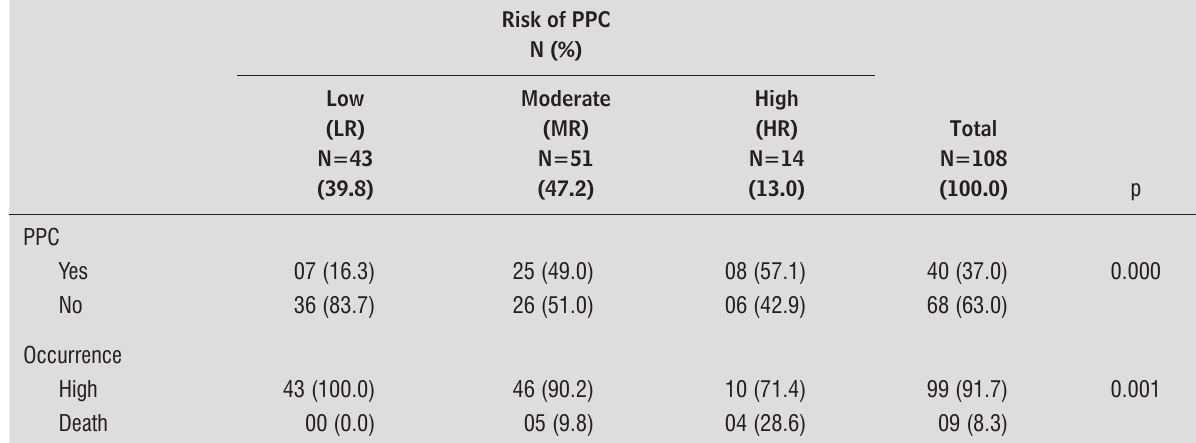
Table 4 - Distribution of patients (n = 108) with respect to the risk of PPC and the occurrence of death and hospital discharge